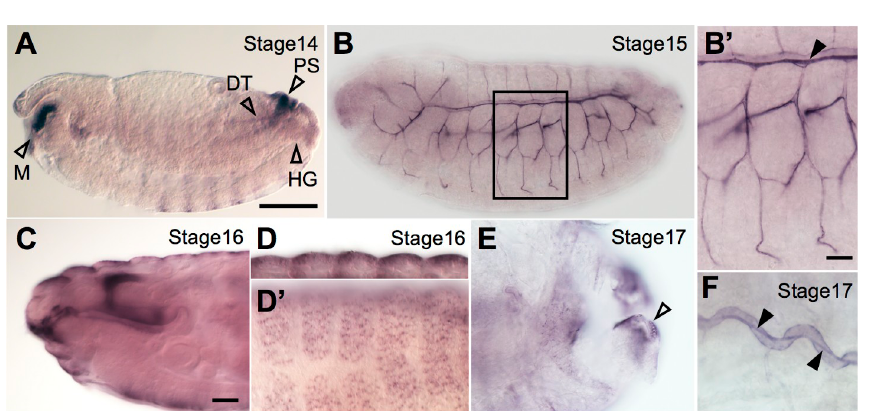
Fig 5. tyn mRNA expression at late embryonic stages. (A) At stage 14, tyn mRNA was expressed in the posterior spiracles (PS), mouth parts (M), hindgut (HG), and part of the dorsal trunk (DT). (B) The tyn mRNA was expressed in the tracheal system most strongly at stage 15. At stage 16, strong expression was observed in the mouth parts (C) and epidermis (D, dorsal view). tyn mRNA expression lasted until stage 17 in the PS (E, dorsal view) and DT (F), but not in the epidermis. Scale bar: 100 μ m for A, B, 20 μ m for B’, C-F. Black arrowheads in B’ and F indicate luminal